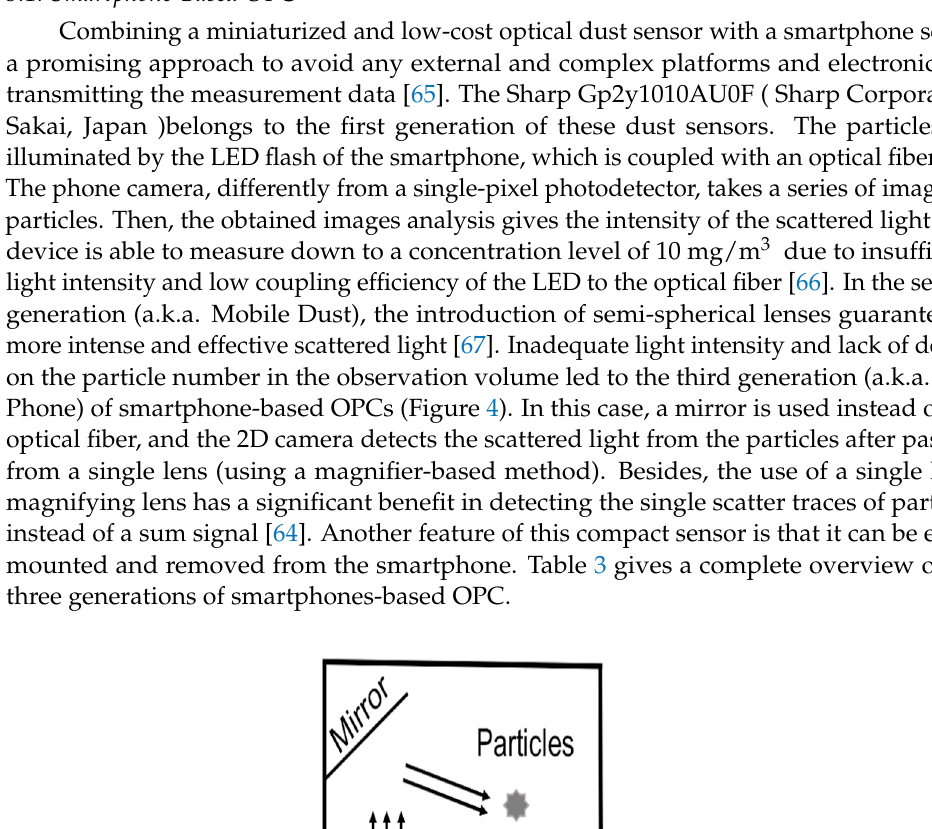
Figure 5. The total schematic of the active OPC. Adapted from ref. [66]. Table 3. Comparison of different PM sensor generation. OPC Based on Smart Phone